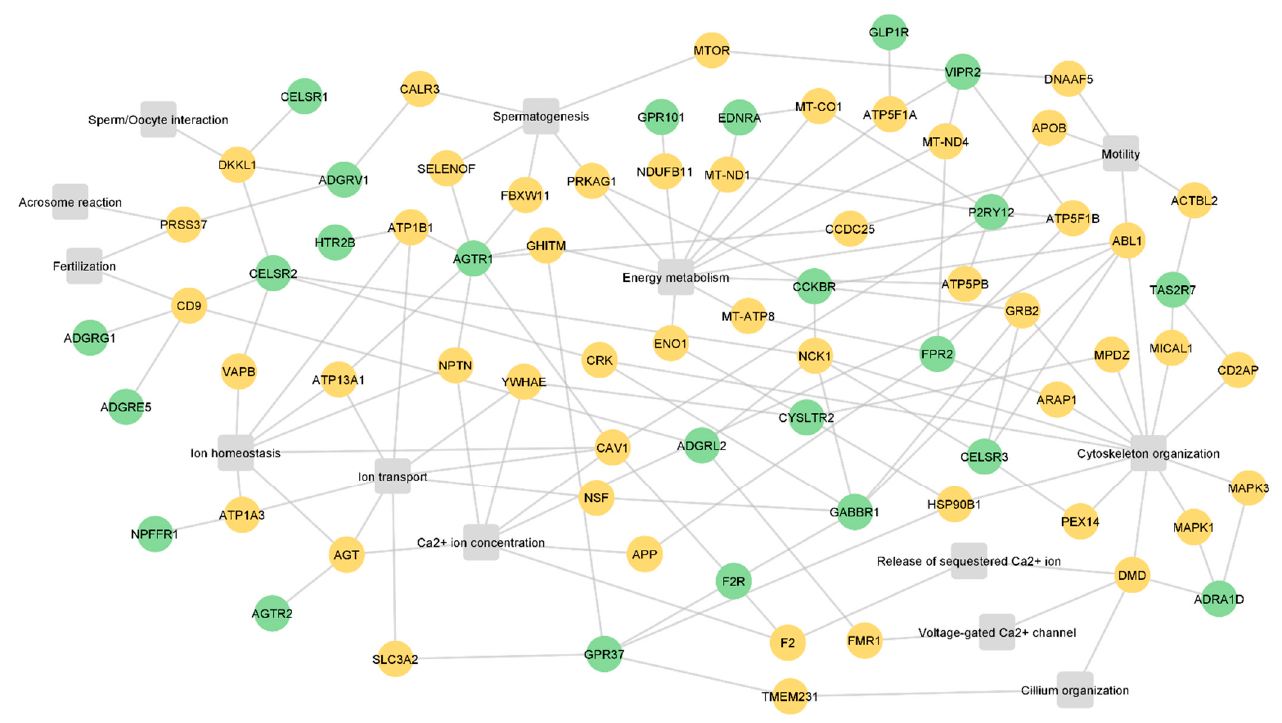
Figure 3. Integrative network of the relevant interactors and sperm GPCRs. The green nodes represent sperm GPCRs (n = 24), the orange nodes are the interactors associated with relevant biological processes to sperm physiology (n = 49), and the grey squares are the biological processes. All proteins are represented by the gene name.